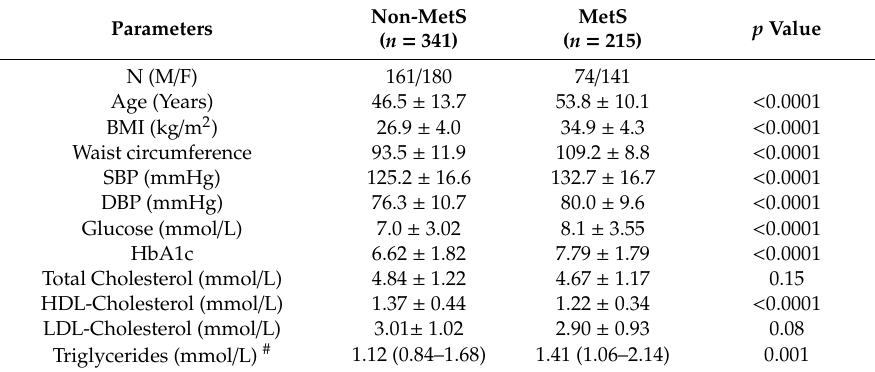
Table 2. Anthropometric and clinical characteristics of the studied